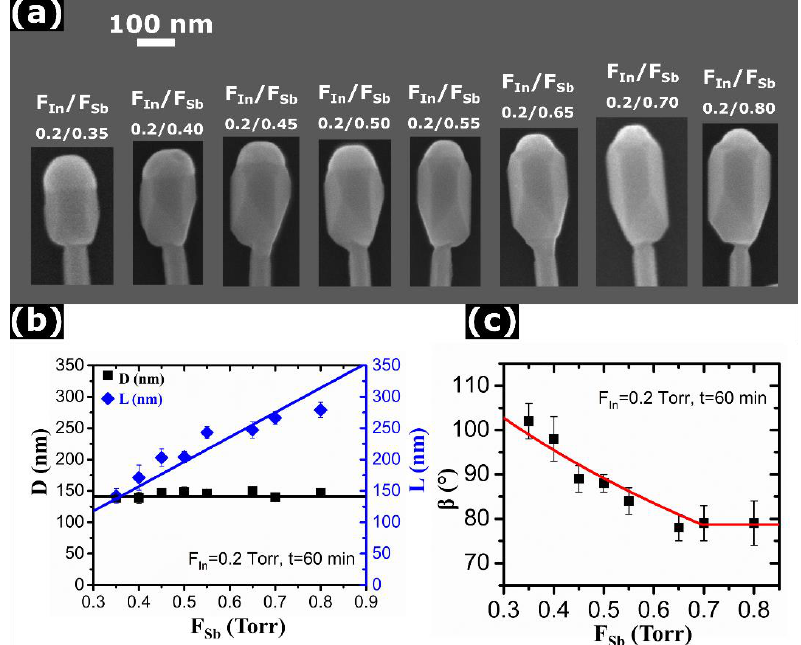
Figure 2. ( a ) Series of SEM images of InAs / InSb NWs, obtained after 60 min of InSb growth at a fixed F In of 0.2 Torr and di ff erent F Sb , yielding di ff erent In / Sb line pressure ratios as indicated in each panel. The droplets become smaller than the NW facet for higher F Sb . ( b ) Diameter and length of InSb segment versus the F Sb (symbols). ( c ) Contact angle of In droplets on top of InSb segments versus F Sb (symbols). The lines in (b) and (c) are theoretical fits discussed in the modeling part. The change of the slope in the model fit comes from the minimum stable contact angle of 79°.